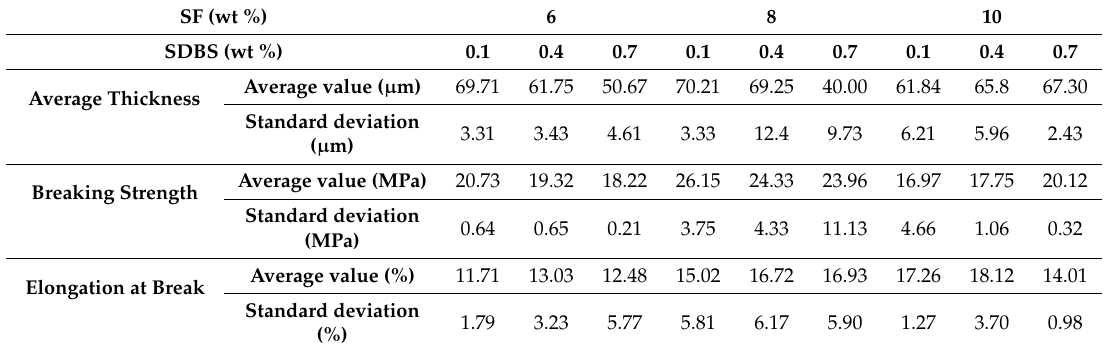
Table 4. Mechanical properties of SF nanofiber membranes when the gas flow volume was 50 m 3